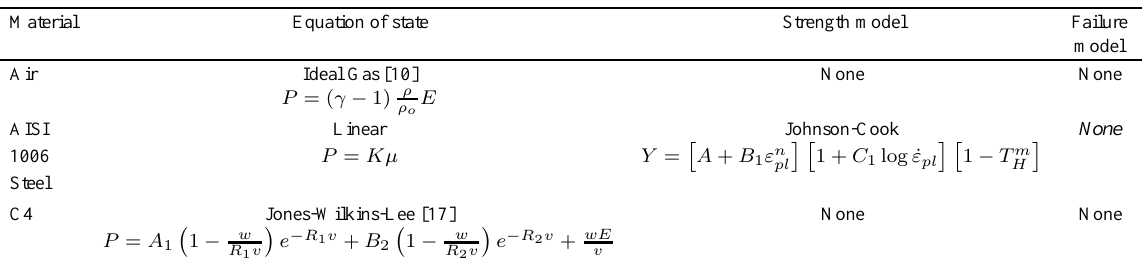
Table 3 Material Models used for Air, AISI 1006 Steel and C4 used in the present work. Model parameters can be referenced from AUTODYN